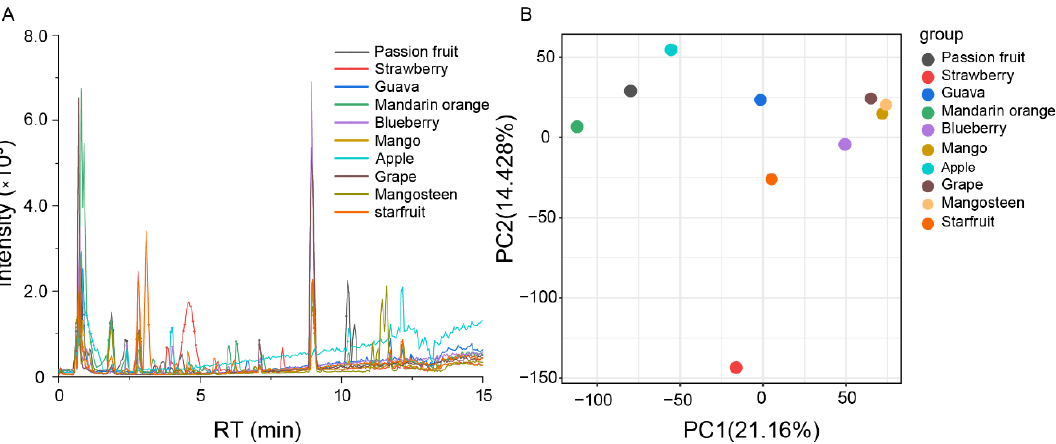
Figure 1. Analysis of metabolic variation in ten fruits using Q Exactive Focus Orbitrap LC-MS/MS. ( A ) Total ion chromatography of metabolites in ten kinds of fruits. ( B ) Principal component analysis (PCA) of the total ion chromatography of ten kinds of fruits.